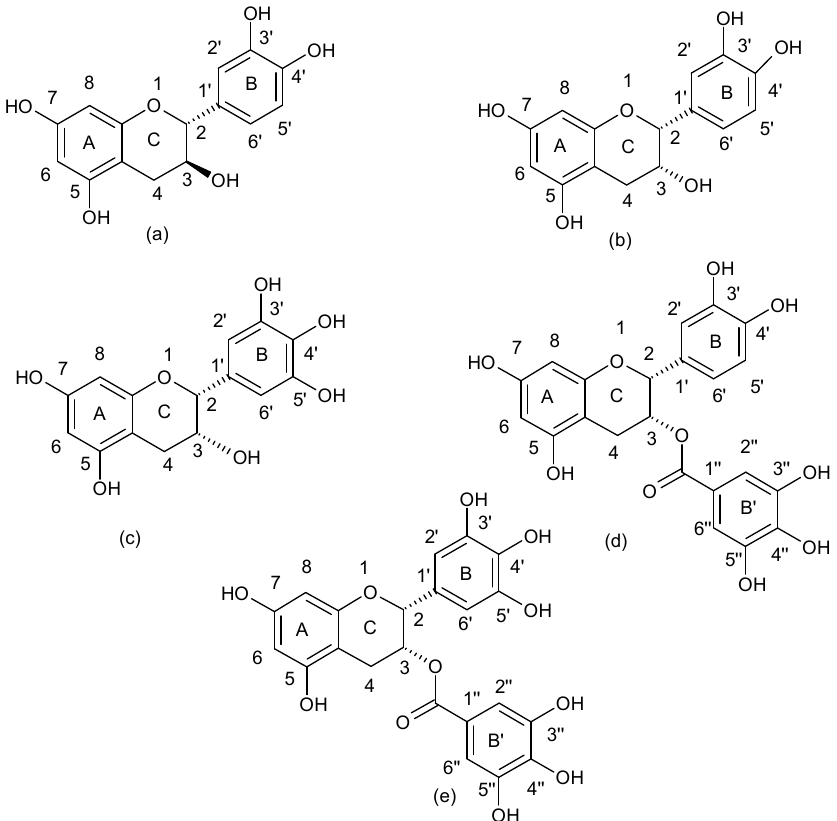
Figure 6. Chemical structure of ( a ) flavanols: catechin, ( b ) epicatechin, ( c ) epigallocatechin, ( d ) epicatechin gallate and ( e ) epigallocatechin gallate.